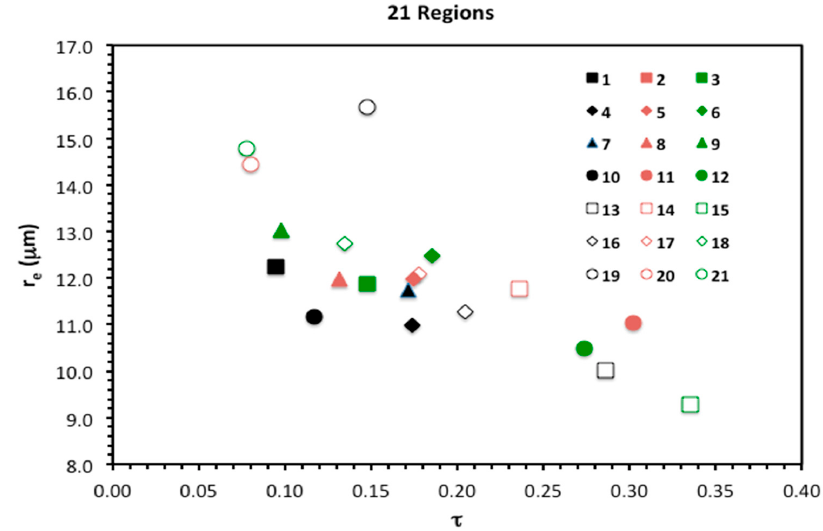
Figure 12. Scatter plot of regionally averaged AOT vs. CDER for their long-term averaged monthly mean values in the 21 regions listed in Table 1.